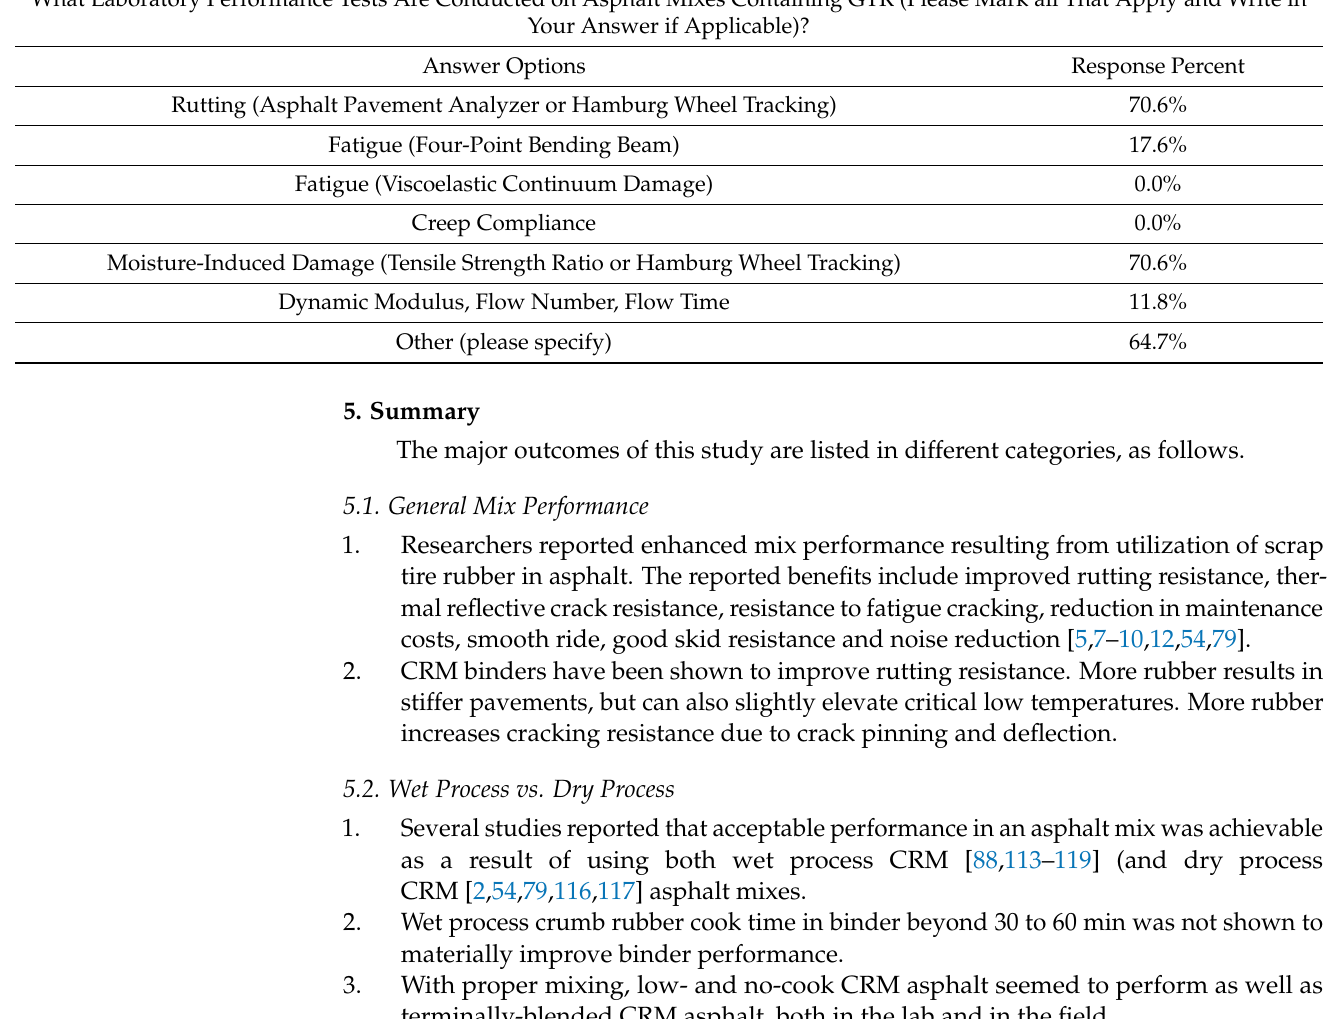
Table 18. Laboratory tests conducted on asphalt mixes containing